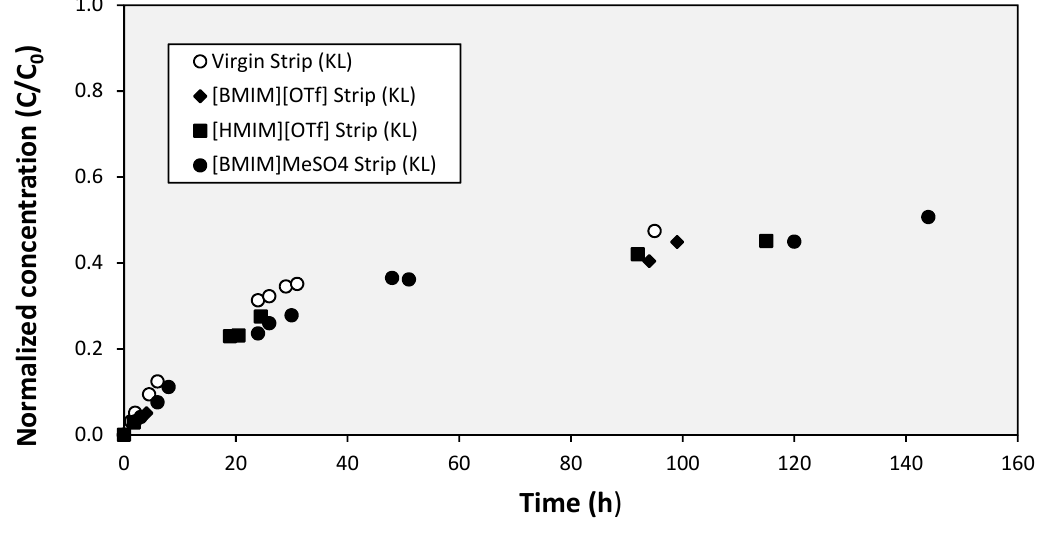
Figure 8. Evolution of the concentration of Kraft lignin in the stripping compartment with virgin HPVDF membrane and three SILMs supported in HPVDF.